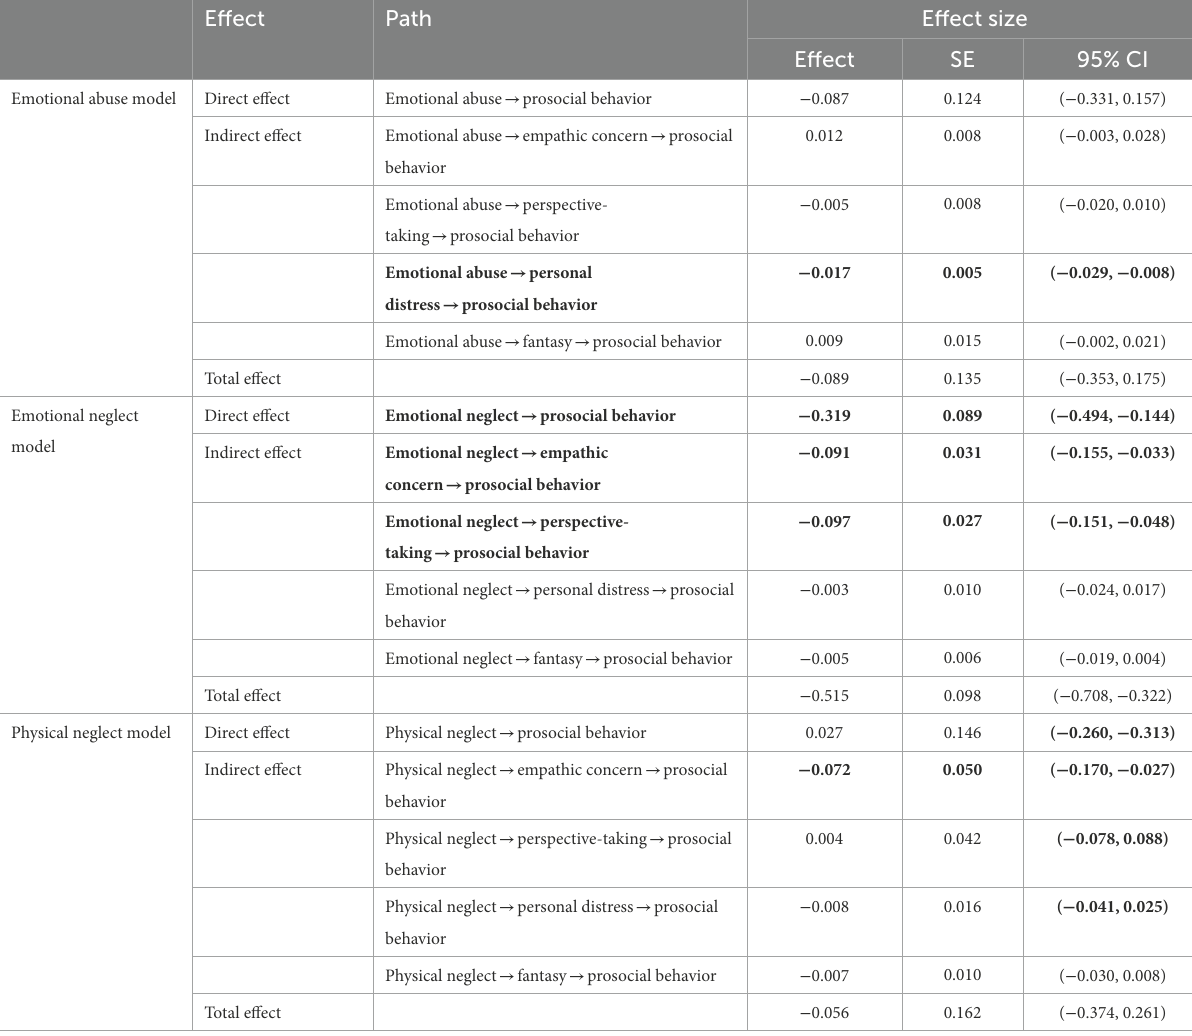
TABLE 4 The paths and effect analysis between childhood abuse, neglect, and prosocial behavior ( N = 1,569).